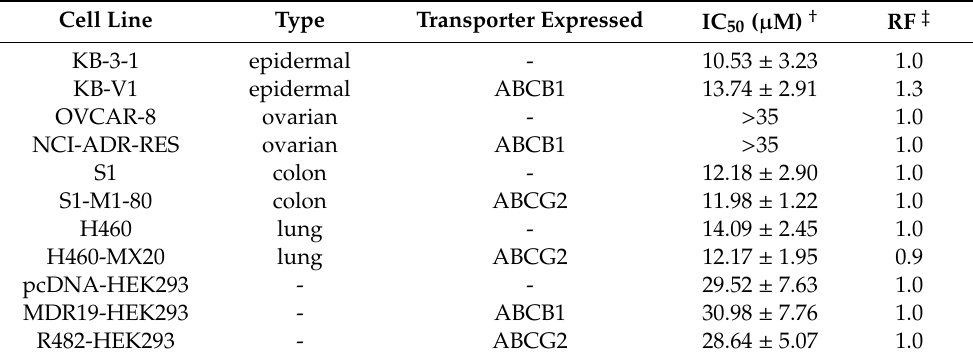
Table 4. Cytotoxicity of TMP195 in human cell lines overexpressing ABCB1 or